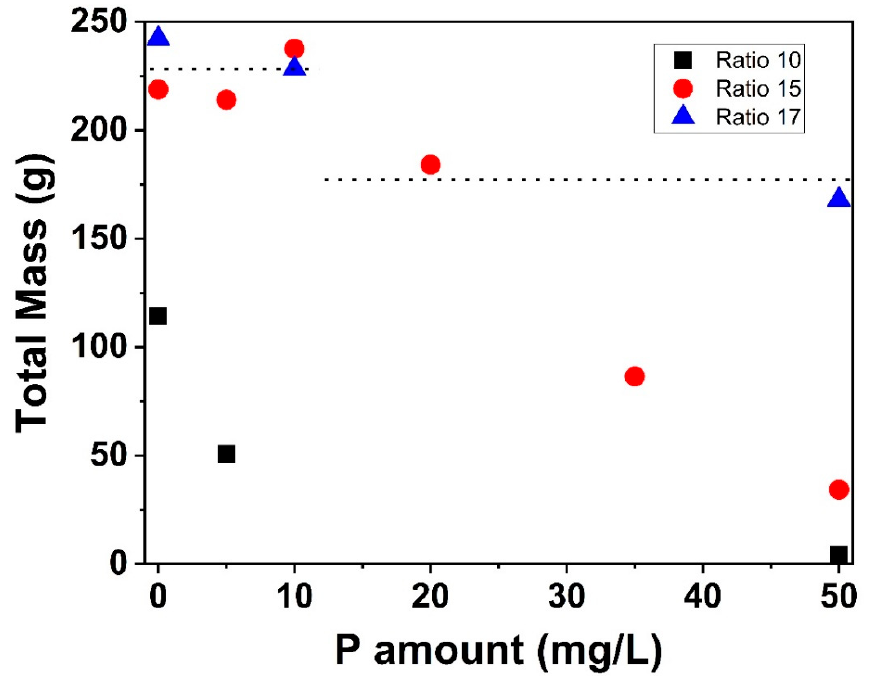
Figure 3. Variation of the measured total deposited mass within the PHE as a function of the added P for a 0.5% ( w / v ) WPI solution and three different Ca/ β -lactoglobulin ( β -lg) molar ratio as a model fluid. The square is for ratio 10, circle for ratio 15, and triangle for ratio 17. Dotted lines are given for guiding eyes.